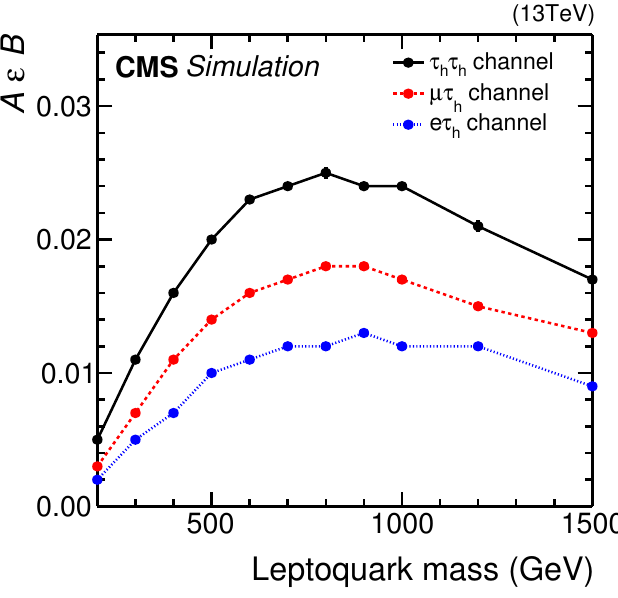
Figure 2 . The product of acceptance, e(cid:14)ciency, and branching fraction as a function of m LQ for the single production of LQs in each of the three channels considered: (cid:28) h (cid:28) h (black solid line), (cid:22)(cid:28) h (red dashed line), and e (cid:28) h (blue dotted